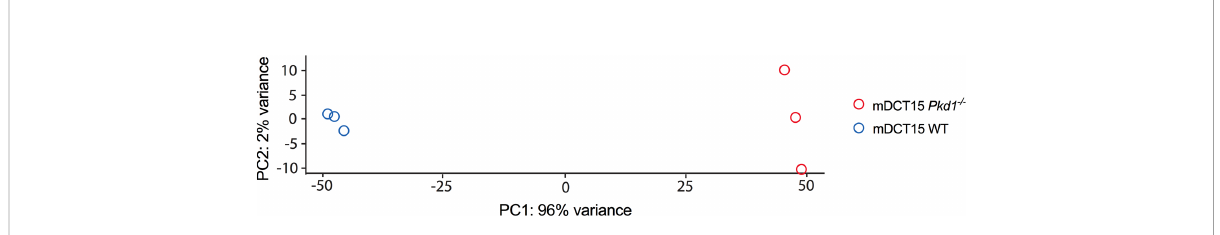
FIGURE 4 Principal component analysis of the RNAseq data transcripts of wild type and Pkd1 -/- mDCT15 cells. The plot depicts a clear separation between the Pkd1 -/- mDCT15 cell samples (red circles) and the wild type mDCT15 cell samples (blue circles) (n = 3/group).